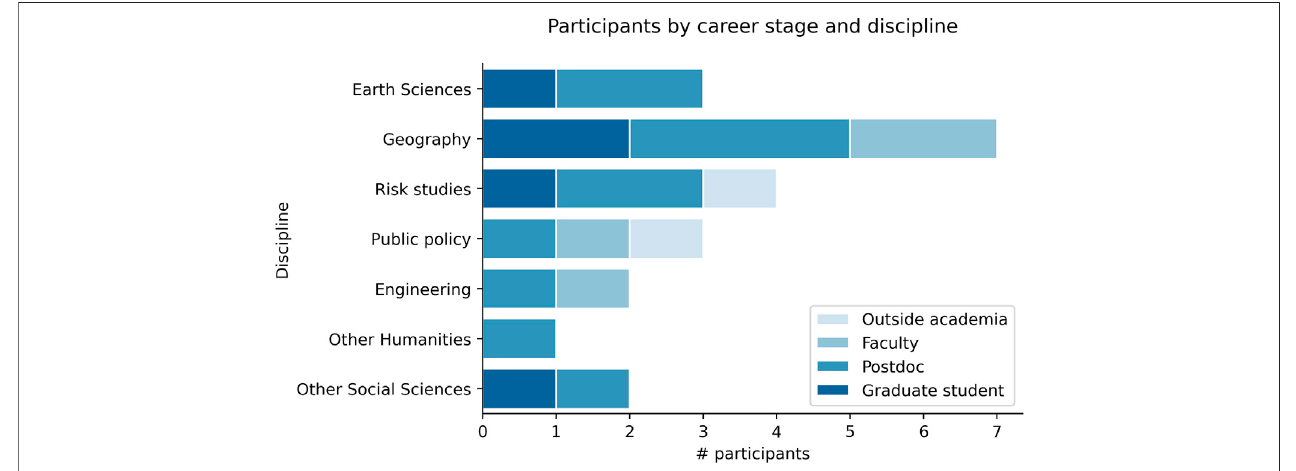
FIGURE2| Numberofparticipantsineachdiscipline,subdividedbycareerstage.Wehavegroupedrelateddisciplinestocapturetheareaofparticipants ’ research and maintain anonymity.